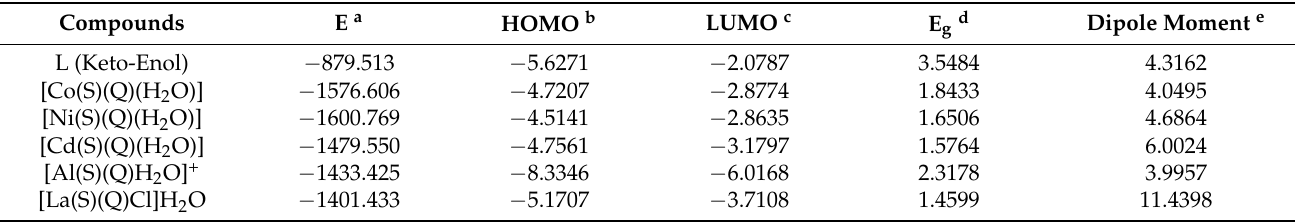
Table 7. Calculated energies for Schiff bases and their complexes at B3LYP/6-311++g(d,p) for all atoms and at B3LYP/LANL2DZ level of theory for metal